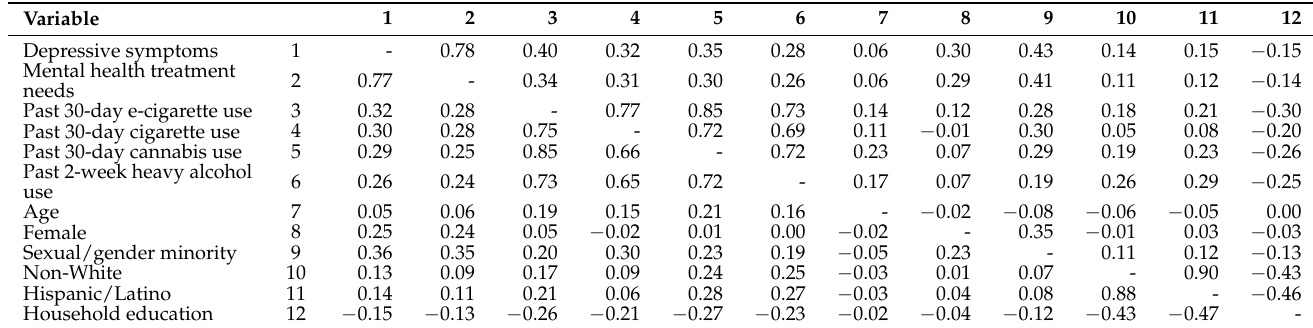
Table 2. Bivariate correlations among variables in the analytic